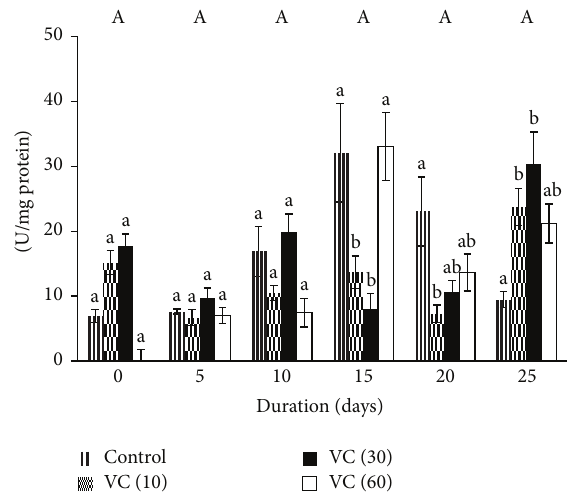
Figure 1: Superoxide dismutase activity in plasma isolated from stored blood. Values are mean ± SE of five animals/group. VC (10): vitamin C (10mM); VC (30): vitamin C (30 mM); and VC (60): vitamin C (60mM). Two-way ANOVA was performed between the groups and subgroups. Changes between the groups are insignifi- cant.Changeswithinthegroupsarerepresentedinlowercase.Those not sharing the same letters are significantly different.